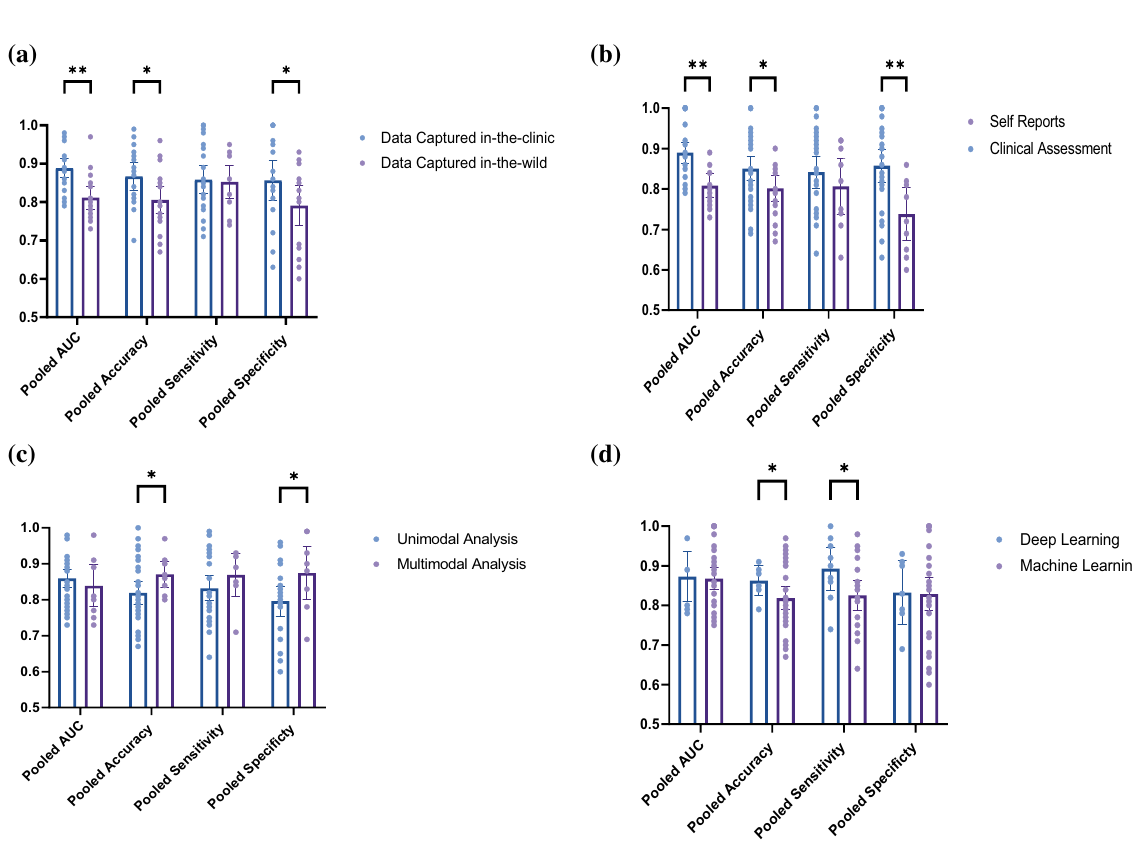
Figure 5. Scatter–Bar plots for the Subgroup Analysis results for ( a ) data collected in-the-clinic vs. data collected in-the-wild, ( b ) clinically validated data vs. self-reported data, ( c ) multimodal analysis vs. unimodal analysis and ( d ) deep learning vs. other machine learning classifiers. The dots represent the individual studies and the height of the bars corresponds to the outcome of the random effects meta-analysis model with 95% CI. ** denotes p < 0.005 and * denotes p <